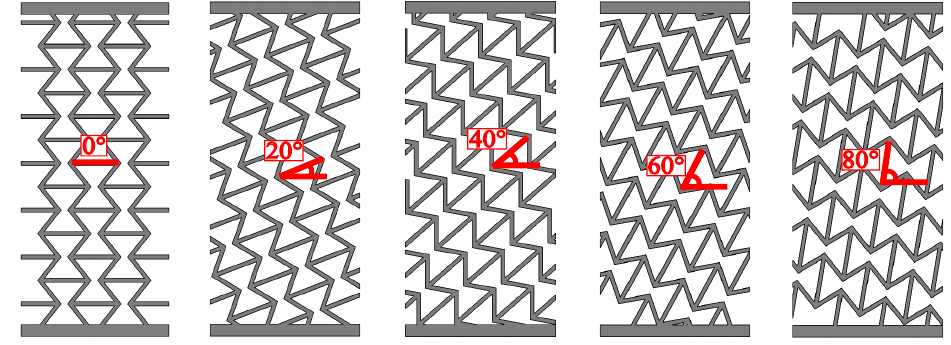
Figure 3. Example of re-entrant lattice-flexure hinge schematics with a unit cell dimension of 5.5 mm at orientations of 0°, 20°, 40°, 60°, and 80° with respect to their principal